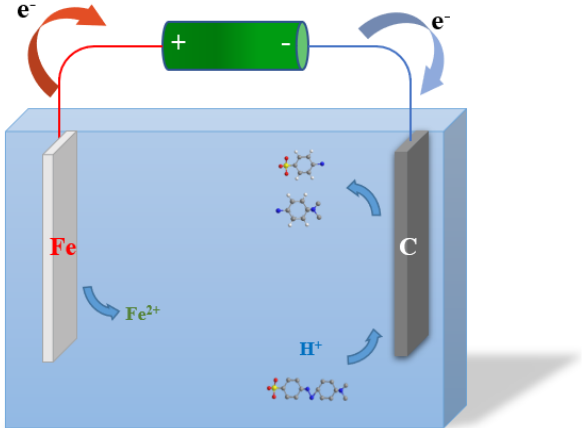
Figure 18. Mechanisms of the filler treatment of methyl orange wastewater.